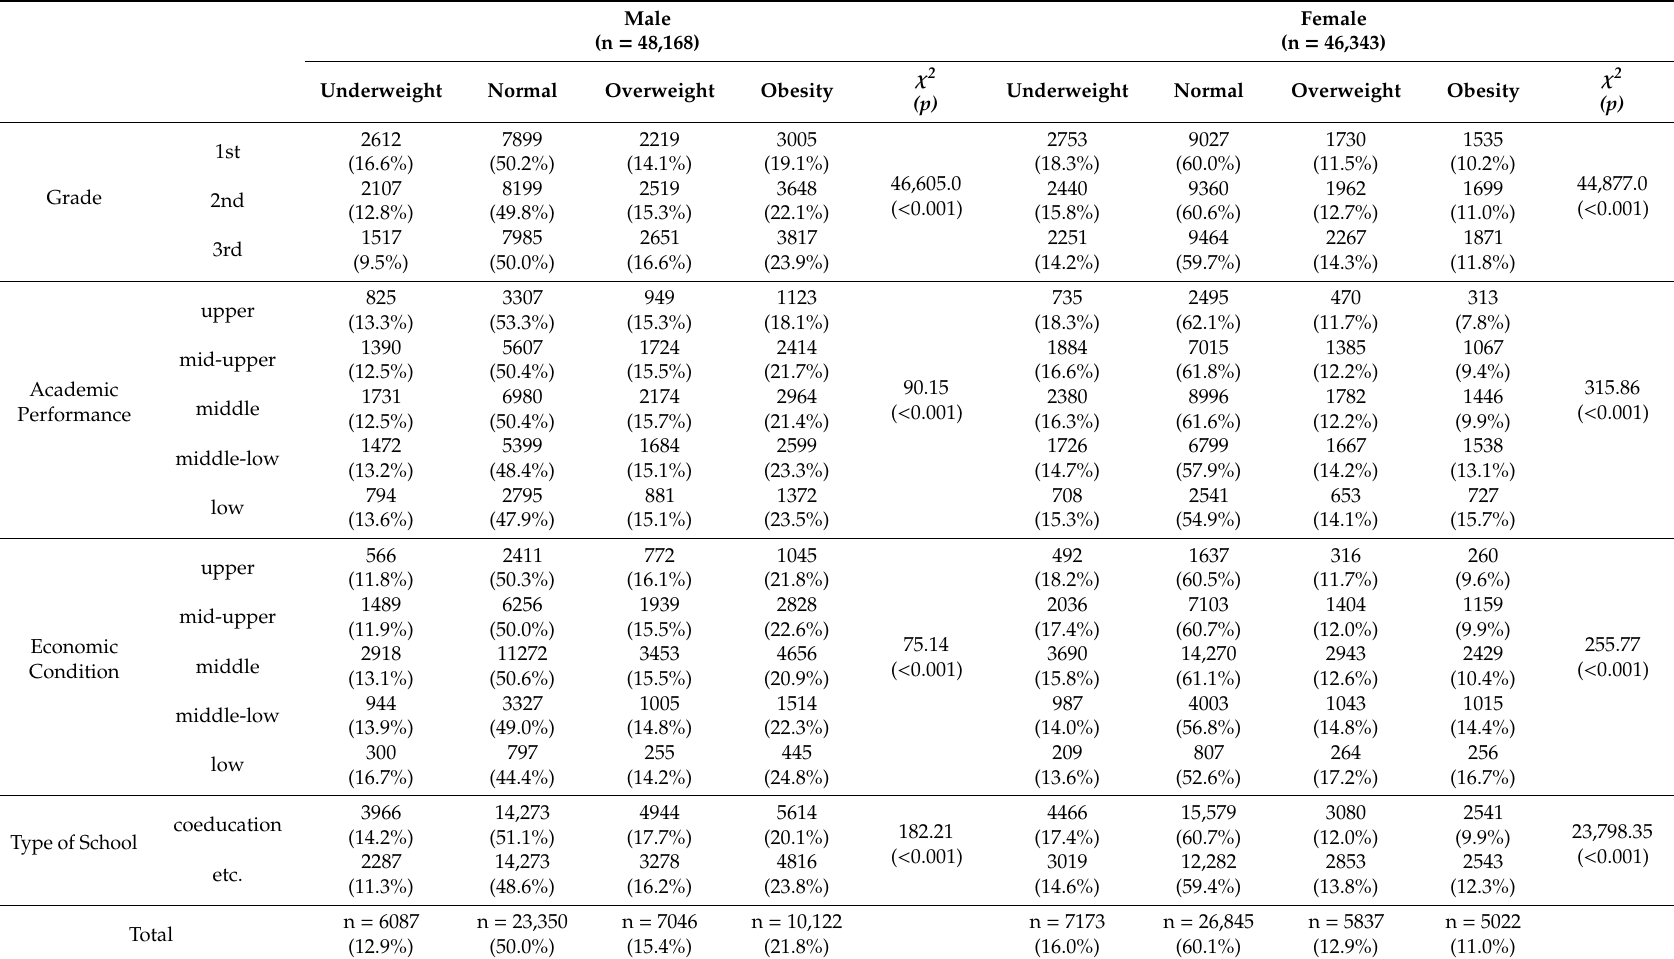
Table 2. Relationship between General Characteristics and youth